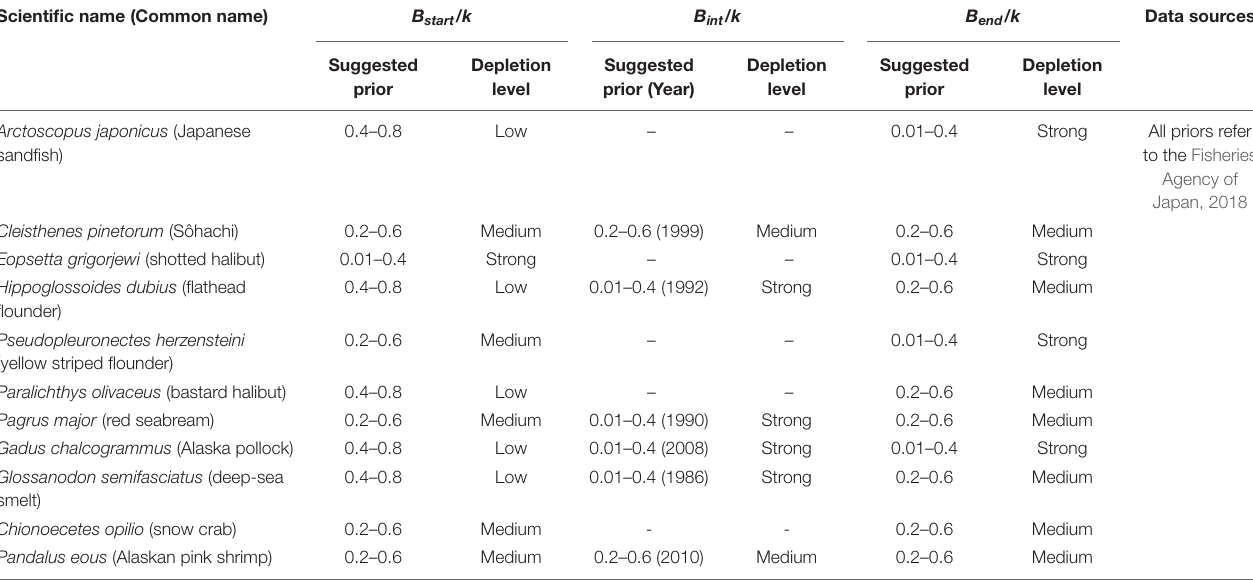
TABLE 3 | Suggested ranges of B start / k , B int /k , and B end / k for the period before catch data became available*.